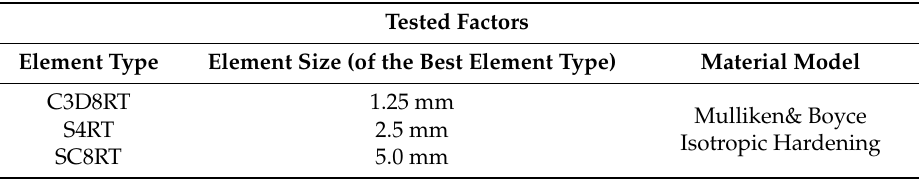
Table 3. Element type, element size, and material model tested in the numerical tests.